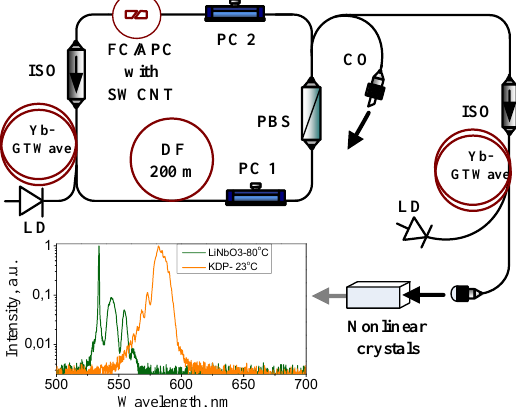
Fig. 1 The optical design of the experimental setup and the spectra obtained by radiation: LD- laser diode, CO- control output, ISO- optical isolator, DF- delay fiber, PC 1,2- polarization controller, PBS- polarized beam splitter. After amplification of the MO radiation, experiments were performed to the frequency doubling of the ytterbium-doped laser. A KDP(KH2PO4), CDA (СsН2АsO4), and LiNbO3 crystals were used to get radiation at wavelengths of 530-580 nm. Also, for such crystals as LiNbO3 and CDA, a heating element with a temperature controller was used to achieve 90-degree synchronism. Also, for such crystals as LiNbO3 and CDA, a heating element with a temperature controller was used to attain 90-degree synchronism because the refractive indices of crystals significantly depend on the temperature of samples. The average output power was up to 1 mW. It can be expected that such a laser may find application in medicine to treat red telangiectasia [3] and in ophthalmology